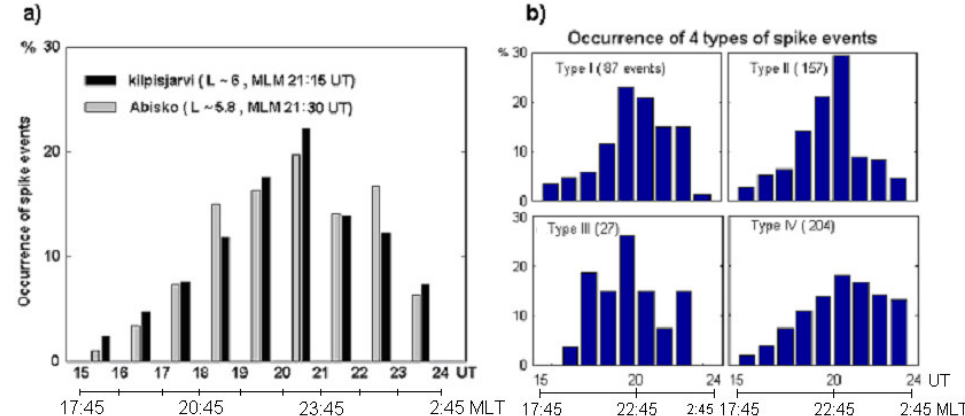
Fig. 2. (a) Occurrence of spike events between 17:45-02:45 MLT (15:00–24:00 UT). Black bars are data from IRIS at Kilpisj¨arvi (L ∼ 6.1,Magnetic Local Midnight ∼ 21:15 UT) during 1994–2003. Data in grey bars are study done by Taylor (1986) representing the occurrence of spikes in Abisko (L ∼ 5.8, MLM 21:30 UT) during 1980–1985. (b) Occurrence of 4 types of spikes in the IRIS FoV between 17:45–02:45 MLT (15:00–24:00 UT) during 1994–2003.